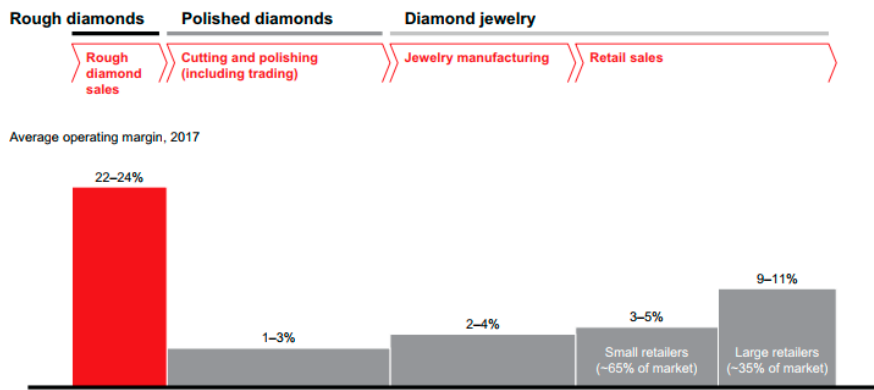
Figure 2. Profit margins of the diamond value chain in 2017. Notes: The figure presents profit margins of the mining value chain in 2017. The analysis of exploration and production is based on data for ALROSA, De Beers Group, Rio Tinto, Dominion Diamond Mines, Petra Diamonds. The analysis of large chains is based on data for Chow Sang Sang, Chow Tai Fook, Gitanjali Jewels, Lukfook, Signet Jewelers, Tiffany & Co., Titan Company. Source : (Bain and Company, Antwerp World Diamond Center 2018).